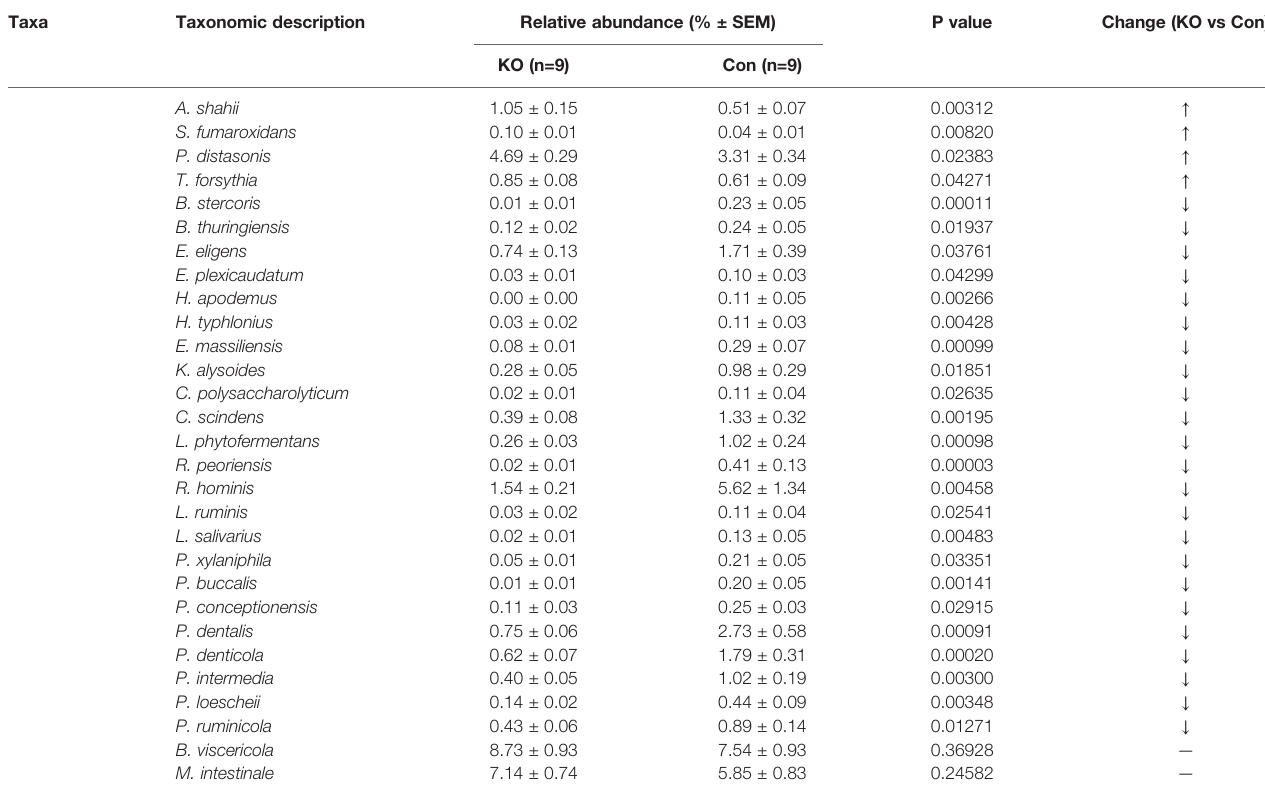
the symbol “ ↑ ” indicates expansion; “ ↓ ” indicates contraction in NHE3 IEC-KO compared with control mice; “—” indicates no difference between genotypes. Unadjusted t-test P values are shown.